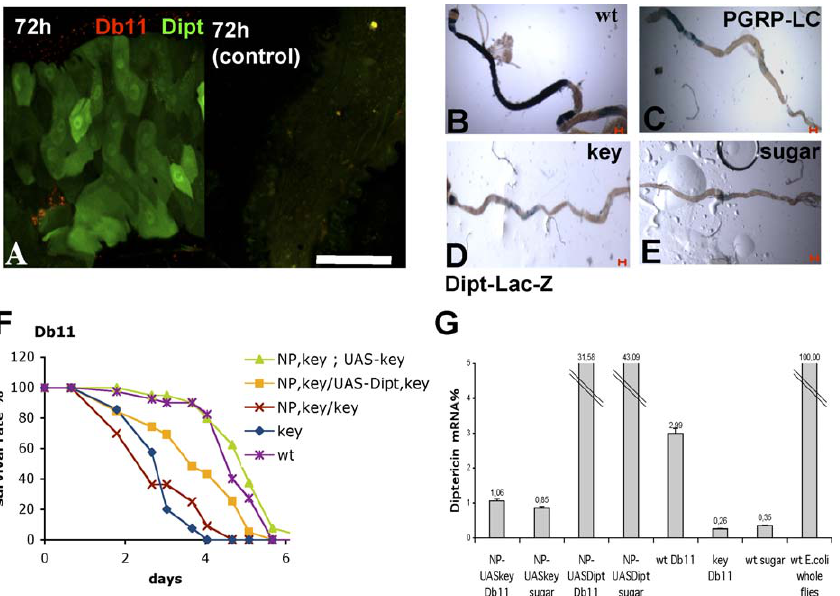
Figure 6. The imd -Dependent Immune Response in the Midgut Mediates Host Defense against S. marcescens Intestinal Infections (A) A Diptericin-GFP transgene is induced in the posterior part of the midgut following an oral challenge with S. marcescens Db11-DsRed (OD ¼ 0, 1, 72 h), as observed by confocal microscopy. Scale bar is 50 l m. (B–E) The expression of Diptericin in the midgut was visualized in dissected preparations of flies carrying a Diptericin-lacZ reporter transgene that have fed on Db11 (B). This expression is reduced in the imd -pathway mutants PGRP-LC (C) and absent in key (D) midguts. The transgene is not induced in flies feeding on sugar solution (E). Scale bar is 150 l m. (F) key mutant flies expressing a Diptericin transgene in the midgut under the control of the NP3084 Gal4 driver (NP3084- Gal4, key/key, UAS-Diptericin) survive longer than key mutants following an oral infection at 29 8 C with Db11 (median survival time [LT50]: 3.7 versus 3.0; p , 0.0001). The rescue of the key mutant phenotype by the expression of a key transgene (NP3084- Gal4, key/key; UAS-key) in the midgut is complete (LT50: 5.1, p , 0.0001). Similar results have been obtained with two other Gal4 drivers that induce the expression of UAS-transgenes in the midgut. Experiments have been repeated twice. NP3084- Gal4, key/key flies die at the same rate as key mutant flies (LT50 2.7 versus 3.0, p ¼ 0.47). (G) Levels of Diptericin transcripts in midgut of wild-type and transgenic flies as measured by quantitative real-time RT-PCR. The normalized signal (using ribosomal protein 49 gene transcript) obtained from extracts of whole flies undergoing a systemic immune response has been arbitrarily set at 100%. The measured values are displayed on the top of each bar. The overexpression of Diptericin induced by the UAS-Dipt transgene (32% and 43% for flies fed with sugar and Db11 [Db11] or sugar alone [sugar]) is much higher than that observed in wild-type flies infected per os